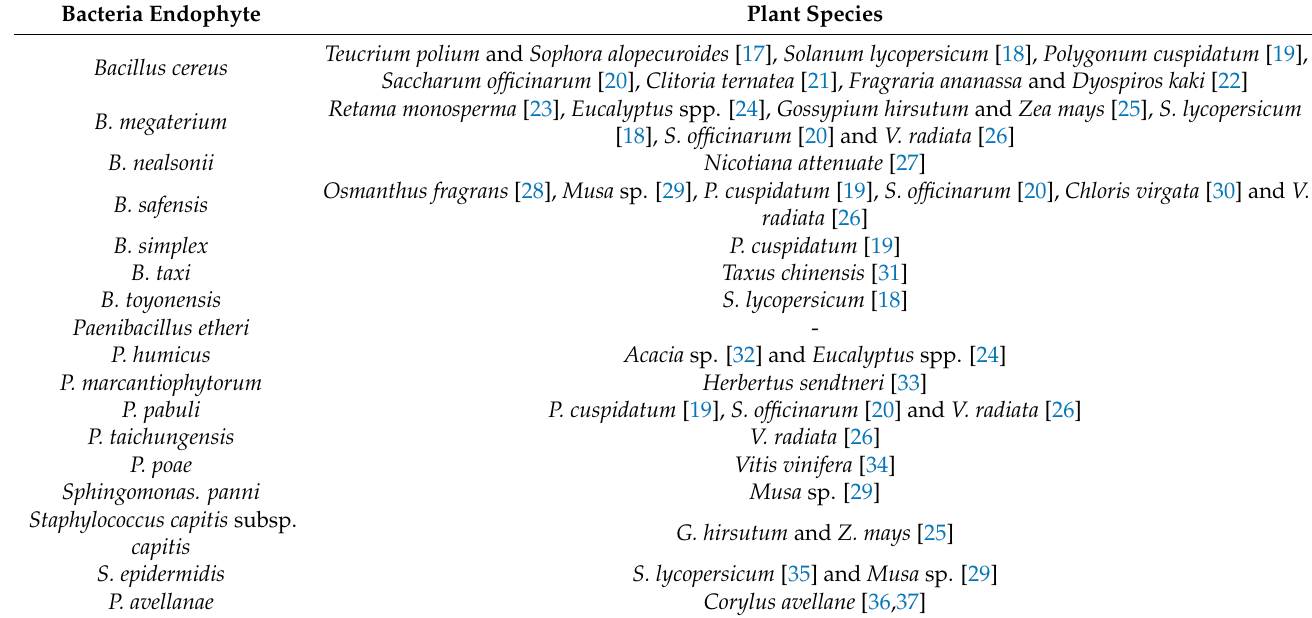
Table 1. Bacterial endophytes isolated from A. unedo and some plant species where these bacteria have been identified